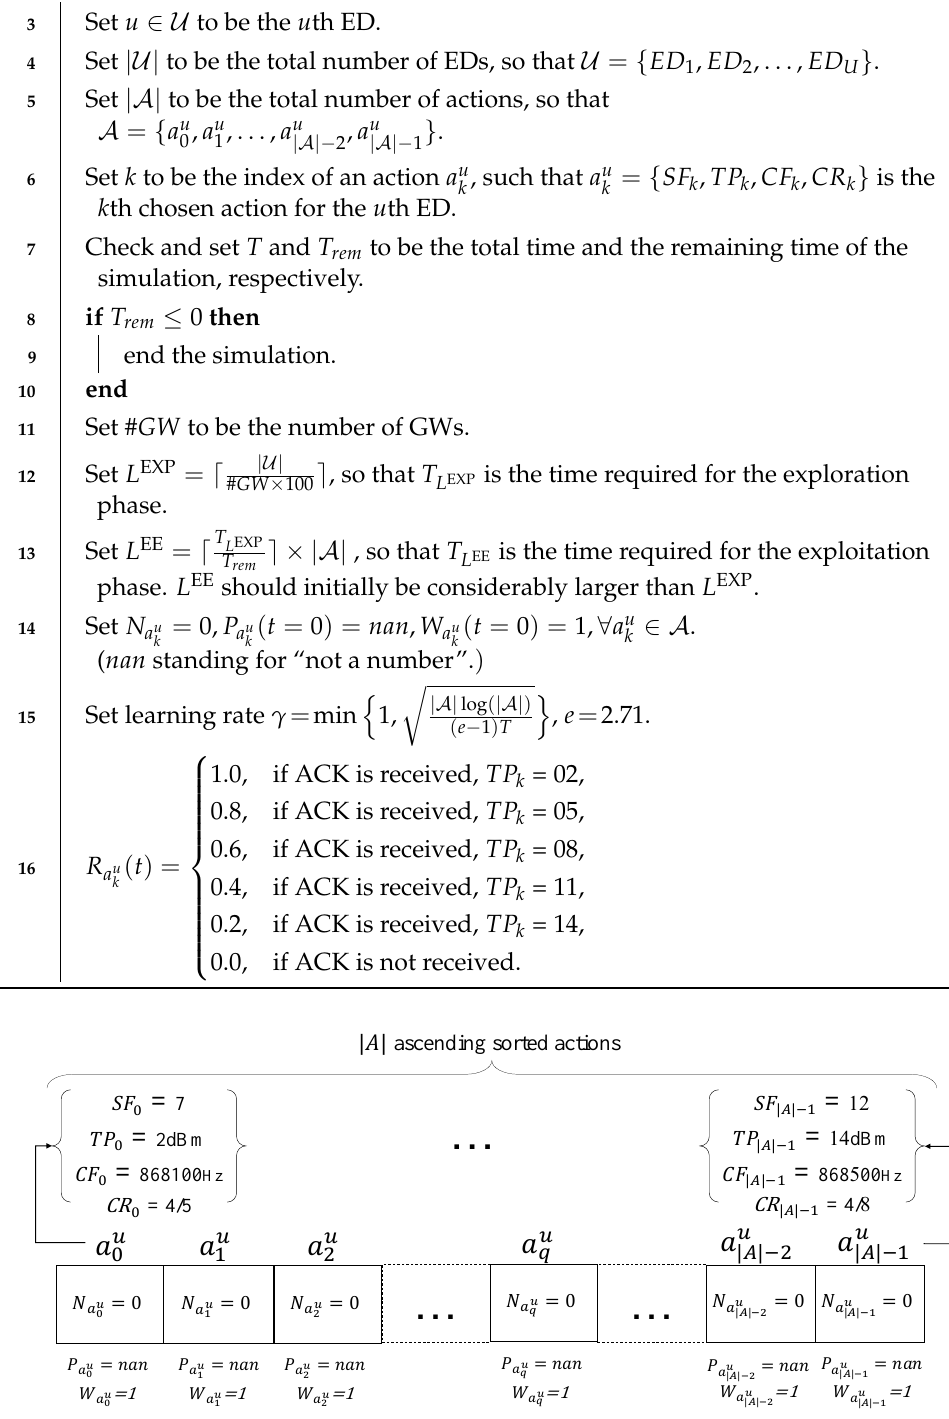
Figure 4. The initialization of LP-MAB for the u th